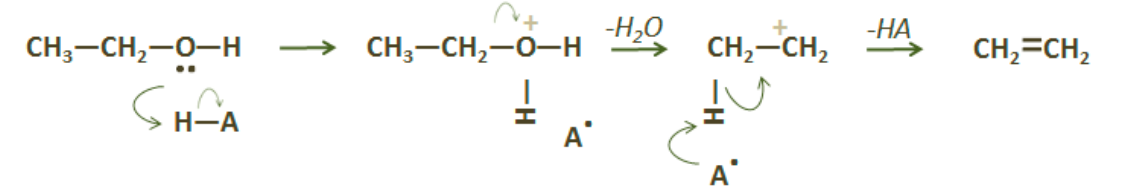
Scheme 2. Mechanism of bio-ethanol dehydration to C 2 H 4 . Table (cid:561) 1. (cid:561) Selected (cid:561) catalysts (cid:561) for (cid:561) bio (cid:556) ethanol (cid:561) dehydration (cid:561) to (cid:561) C 2 H 4 . (cid:561) Table 1. Selected catalysts for bio-ethanol dehydration to C 2 H 4